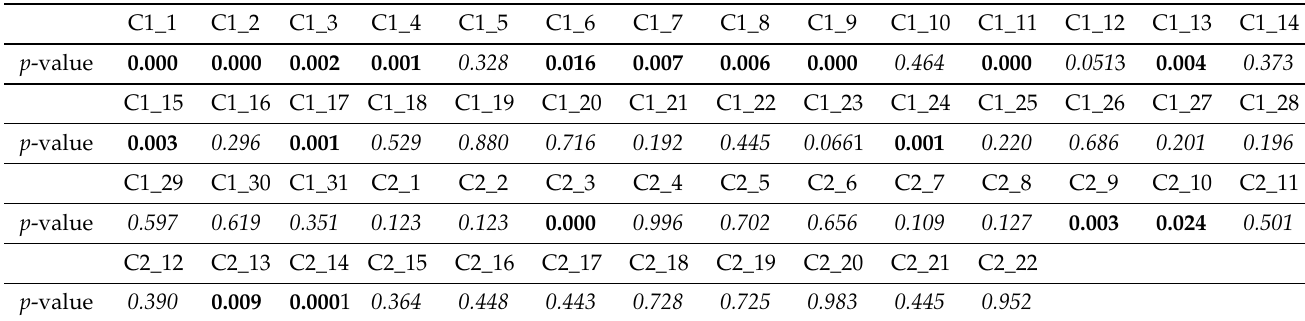
Table 2. p -values obtained for the Mann–Kendall test.